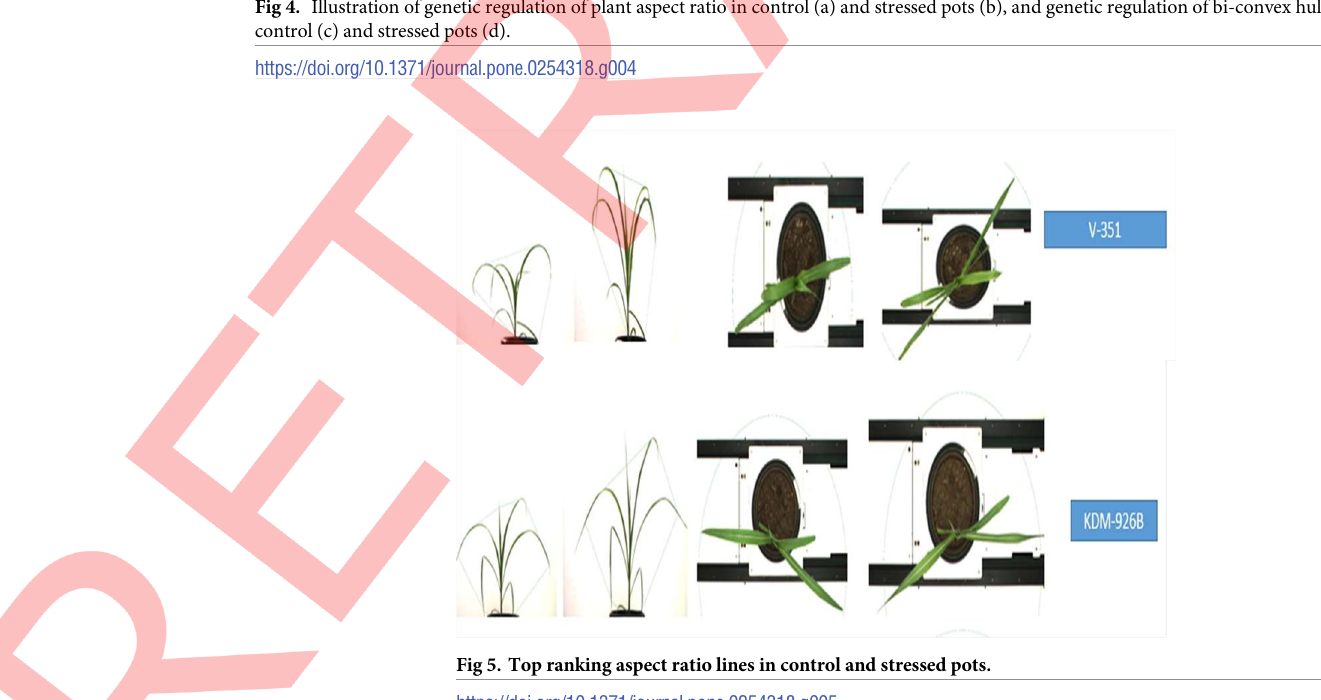
PLOS ONE | https://doi.org/10.1371/journal.pone.0254318 July 27,